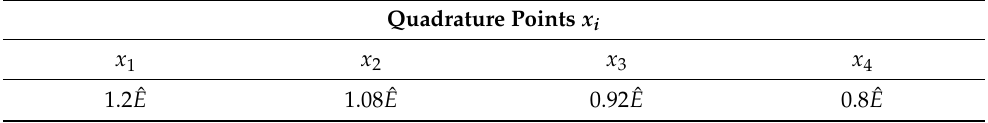
Table 1. List of the four quadrature points x i , calculated using the Gauss–Legendre integration